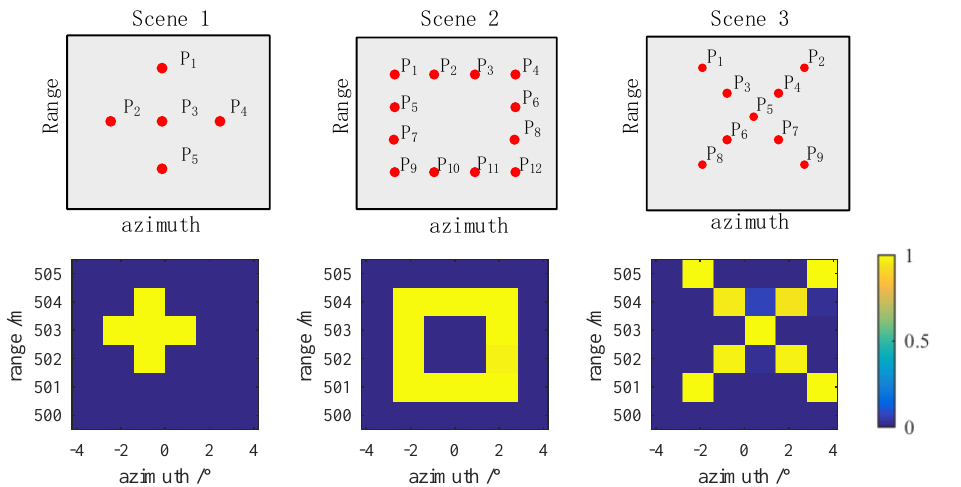
Figure 7. Range-azimuth two dimensional silumations of different imaging scenes.